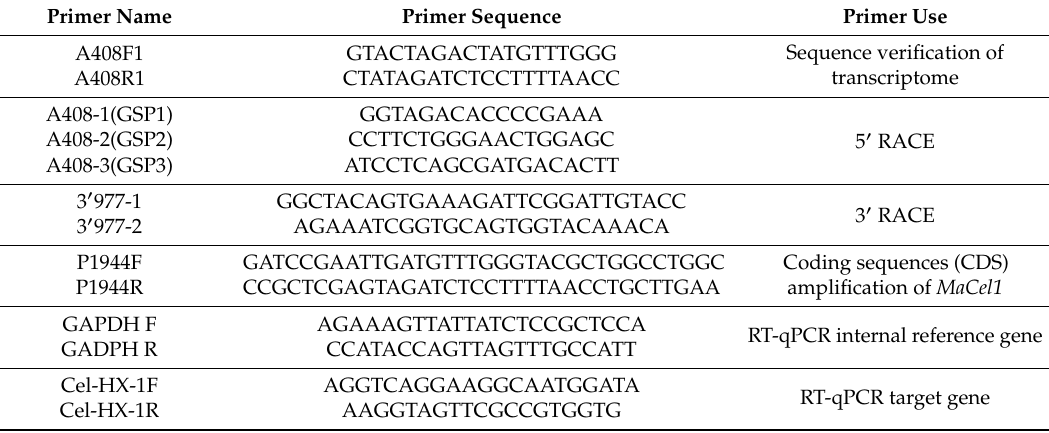
Table 1. Primers used in this